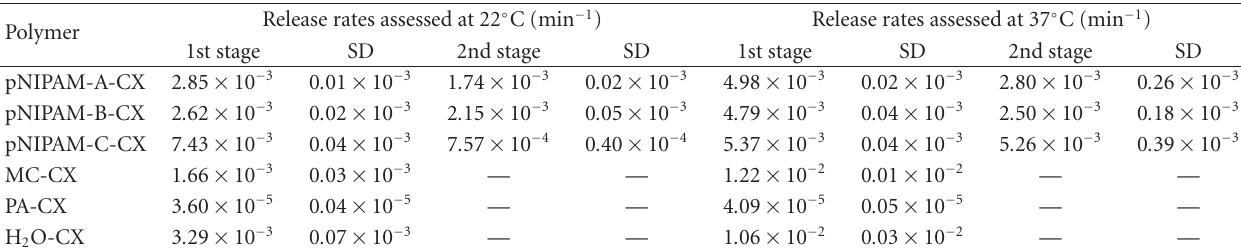
Table 3: Release rates of CX from polymeric preparations.